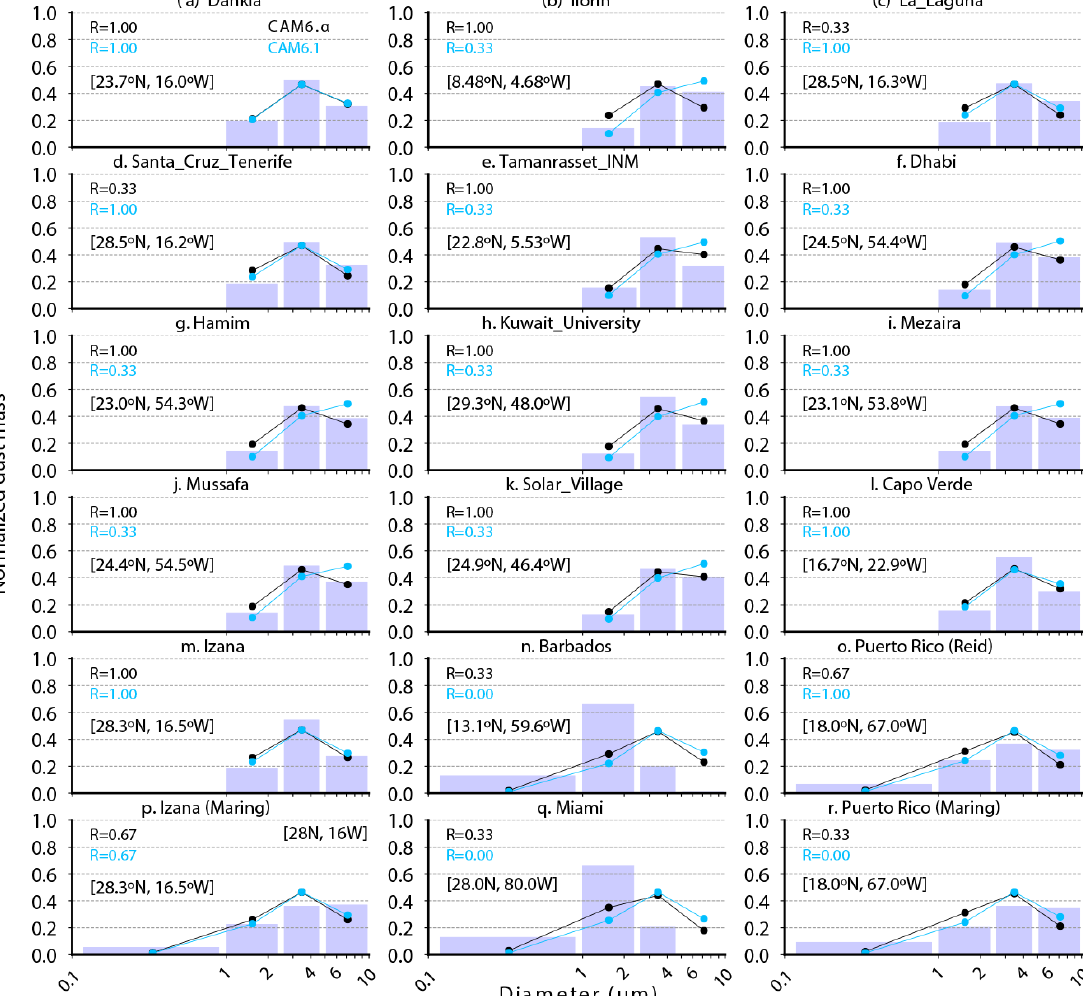
Figure 5. Modeled and observed atmospheric size-resolved dust mass in the geometric diameter range of 1–10µm at AERONET stations. Numbers in each plot indicate the Kendall’s τ coefficient between model and observations (blue bars). The model runs here include the one using the old model with the mode size parameters from CAM6 by default (CAM6.1 in cyan) and the other one using the new model with the mode size parameters from CAM5 (CAM6. α in black). In (a) , only results from CAM6.1 can be clearly seen because the two lines are